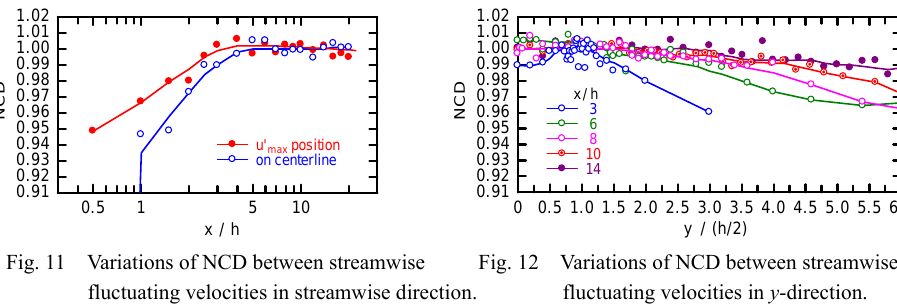
Fig. 11 Variations of NCD between streamwise Fig. 12 Variations of NCD between streamwise fluctuating velocities in streamwise direction. fluctuating velocities in y -direction.